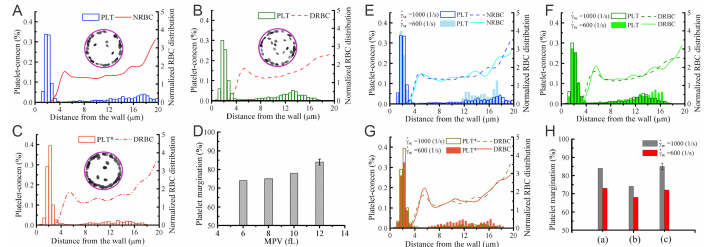
Figure 5. Platelet margination in blood containing healthy and diabetic RBC+platelet. Distributions of platelets and RBCs in the vessel for ( A ) NRBCs+PLTs, ( B ) DRBCs+PLTs (MPV = 6fL), and ( C ) DR- BCs+PLT*s (MPV = 12 fL). ∗ signifies the diabetic platelets. ( D ) Effect of MPV of platelets on platelet margination. ( E – G ) Effects of flow rate on platelet margination. Distribution of RBCs and platelets in the vessel with cell suspensions of ( E ) NRBCs+PLTs, ( F ) DRBCs+PLTs, and ( G ) DRBCs+PLT*. The percentage of marginated platelets φ p for all three cases is summarized in ( H ). ∗ signifies the diabetic platelets. Figures are adopted from [72] with